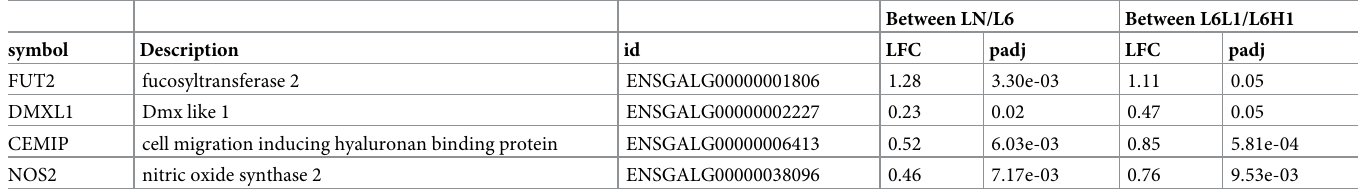
Table 1. Common differentially expressed genes downregulated between LN/L6 analysis and L6L1/L6H1 analysis (potentially associated with resistance to Salmonella ).